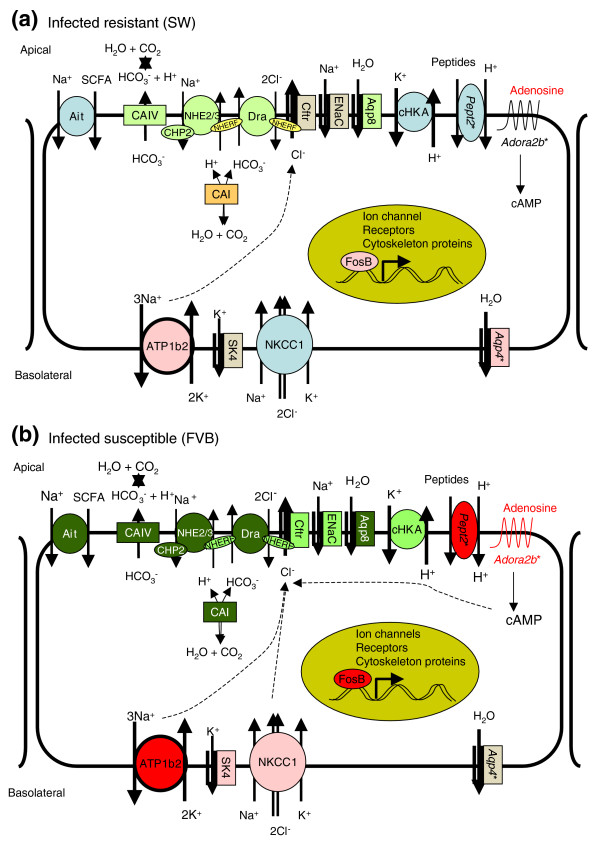
Working model for the pathogenesis of colonic ion transport in fatal diarrhea in C. rodentium-infected FVB mice. Normal ion transport in the large intestine is mediated largely by the coupled action of the anion exchanger DRA, CFTR, sodium/proton exchangers NHE2/3, potassium transporters and carbonic anhydrases (see Discussion). (a) alterations in ion transport in C. rodentium-infected SW mice, including subtle decreases in expression of some apical transporters and compensatory increases in basolateral water channel Aqp4 expression. (b) Profound changes in infected FVB mice consisting of mild to marked downregulation of the majority of apical transporters involved in intestinal Na+ and Cl- absorption and bicarbonate secretion, along with upregulation of basolateral transporters providing the driving force for chloride secretion. In addition, constitutively higher levels of Pept2 and Adora2b expression in FVB mice (indicated by asterisks) can contribute to alterations in cytosolic pH and cAMP during infection, thereby further affecting ion exchange. The cumulative effect may ultimately result in severe diarrhea and lead to death in these susceptible animals. Vesicular trafficking of some proteins (A2B receptor, aquaporins, NHE3, ATPases) and paracellular transport are not addressed here. Colors indicate fold change in gene expression identified by microarray or qRT-PCR: light green ≥2-fold decrease; dark green ≥8-fold decrease; pink ≥2-fold increase; red ≥8-fold increase.